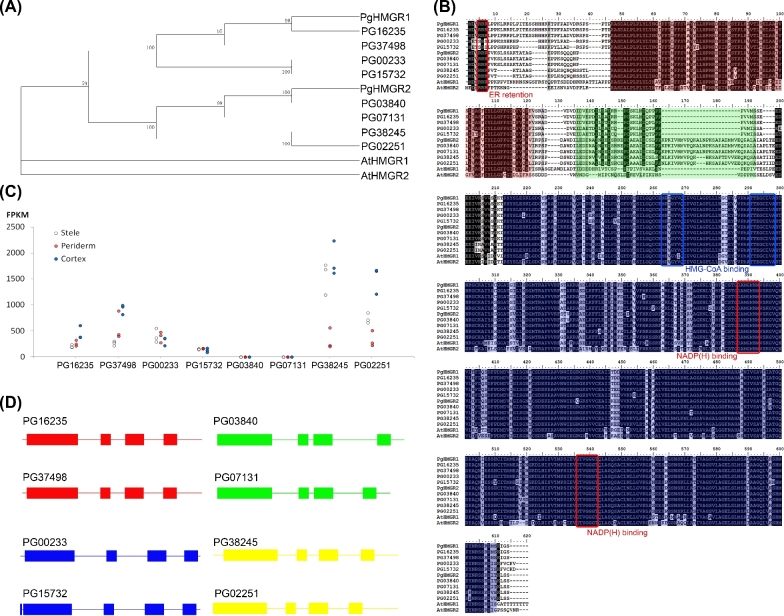
Sequence analysis and transcript levels of the HMGR gene family. (a) Phylogenetic analysis of PgHMGRs and characterized HMGRs from other plants. (b) Multiple alignments of the amino acid sequences of PgHMGRs with homologous HMGRs from Arabidopsis. The black boxes indicate identical residues, and the gray boxes represent identical residues for at least 2 of the sequences. Functional domains are highlighted in colored boxes (red, membrane domain; green, linker domain; and blue, catalytic domain). The 2 putative HMGR-CoA-binding sites, 2 NADP(H)-binding sites, and ER retention motifs are denoted by square boxes. (c) Tissue-specific PgHMGR expression patterns in 4-year-old roots. The data represent the mean ± SD of the 3 independent samples. (d) Genomic DNA structure of PgHMGRs. The exons are represented by the green-filled square boxes. The lines between the boxes correspond to the introns. The numbers above the exons indicate the length in bp.